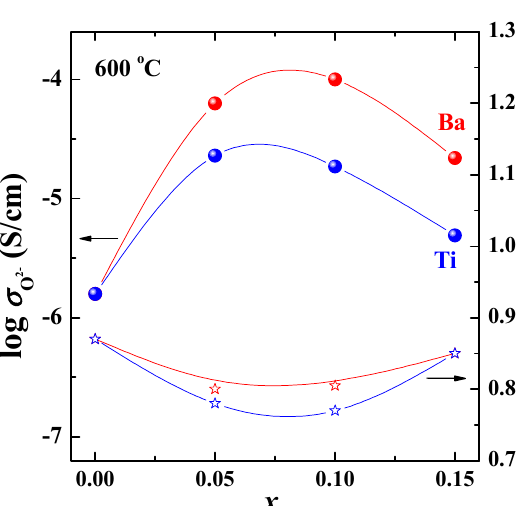
Figure 13. The concentration dependencies of oxygen-ionic conductivities (filled symbols) and activation energies (open symbols) for the solid solutions Ba 1+ x La 1 − x InO 4 − 0.5 x (red) [79] and BaLaIn 1 − x Ti x O 4+0.5 x (blue) [80] at 600 ◦